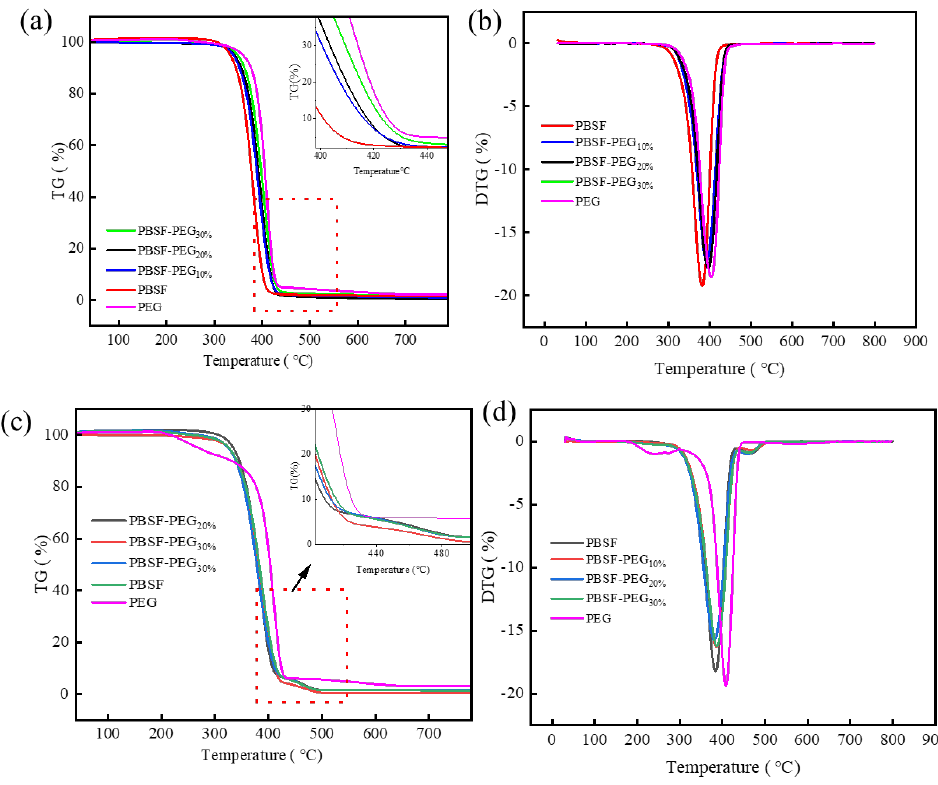
Figure 5. ( a , b ) TGA and DTG curves of PBSF, PBSF-PEG, and PEG in N 2 . ( c , d ) TGA and DTG curves of PBSF, PBSF-PEG, and PEG in air. Table 3. Thermal stability of PBSF and